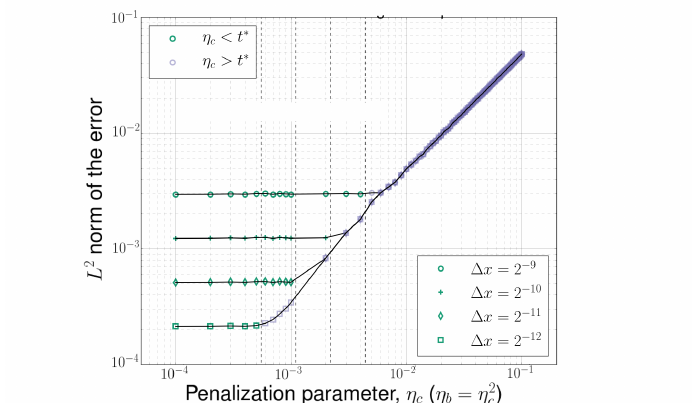
Figure 4. L 2 -norm of the error for different values of η c